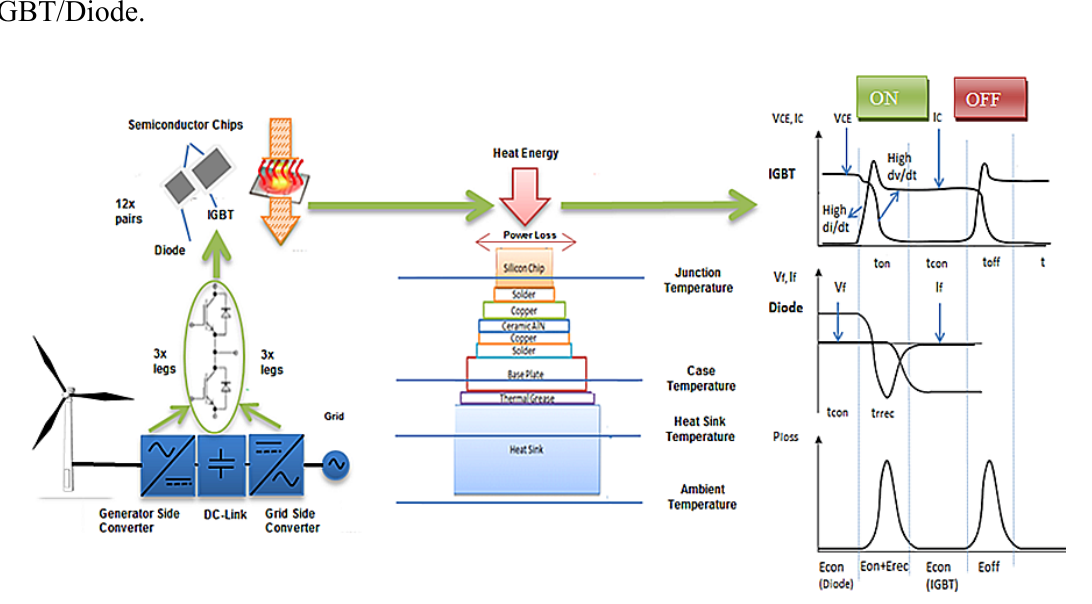
Figure 2. Power loss characteristics of power electronic conversion systems (PECs) in wind applications (modified from